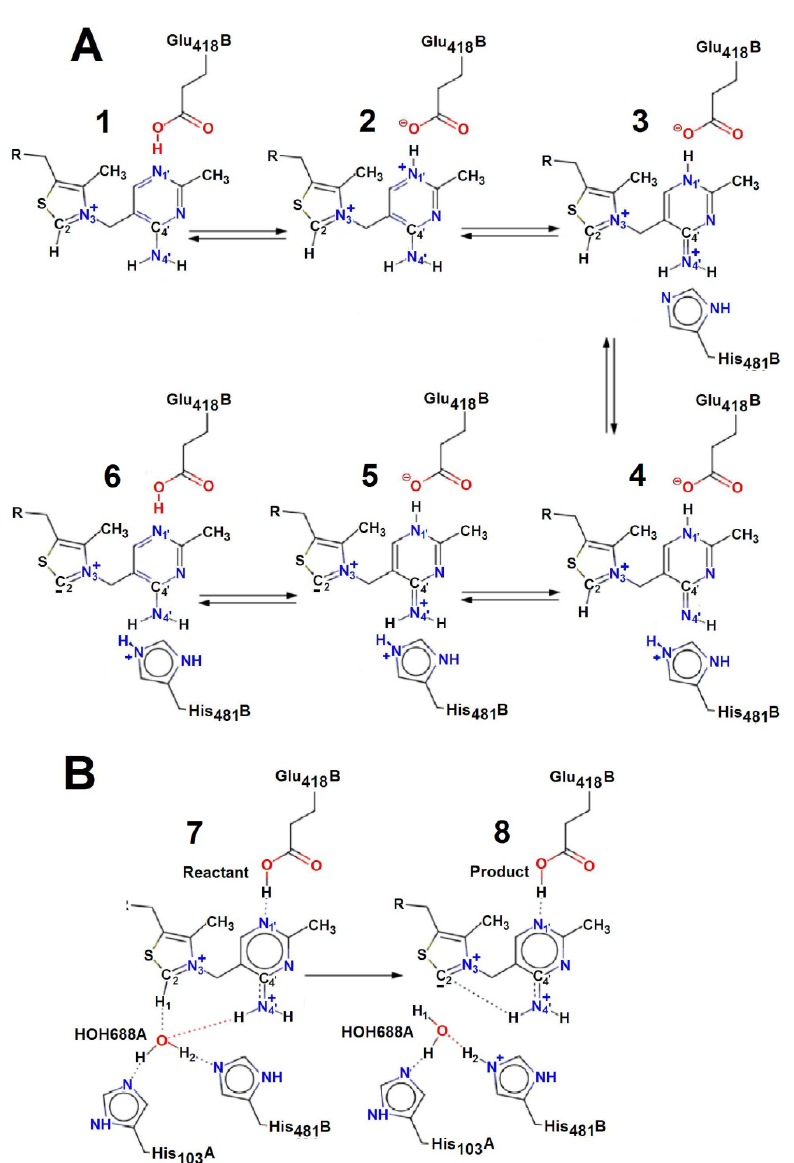
Figure 1. ThDP activation mechanism. ( A )—traditional mechanism, ( B )—mechanism with direct participation of water molecule [18].